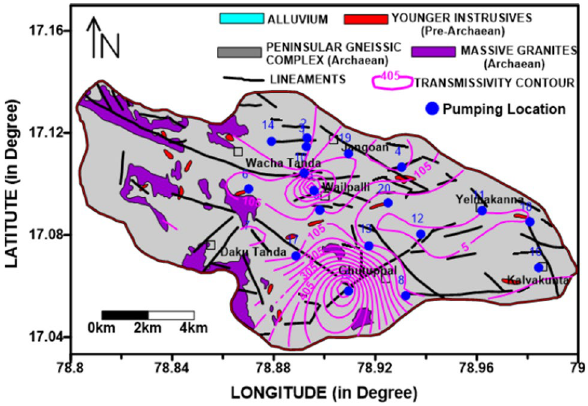
Fig. 9 Variation of transmissivity (m 2 /day) values with geology and